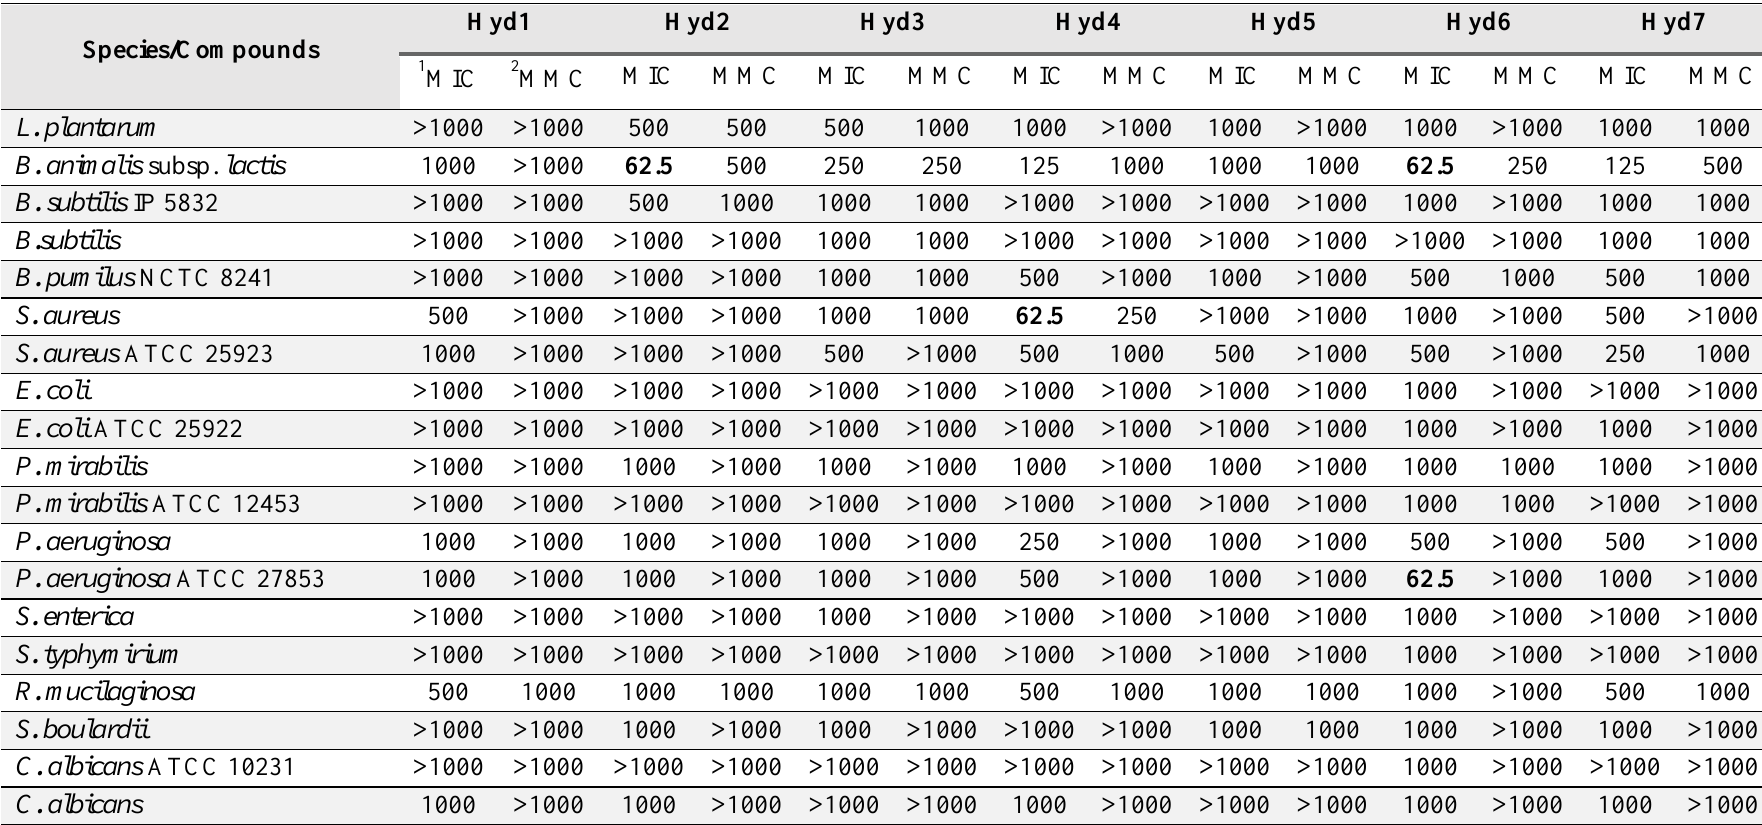
Table 1. Antimicrobial activity of 5-alkenyl hydantoin